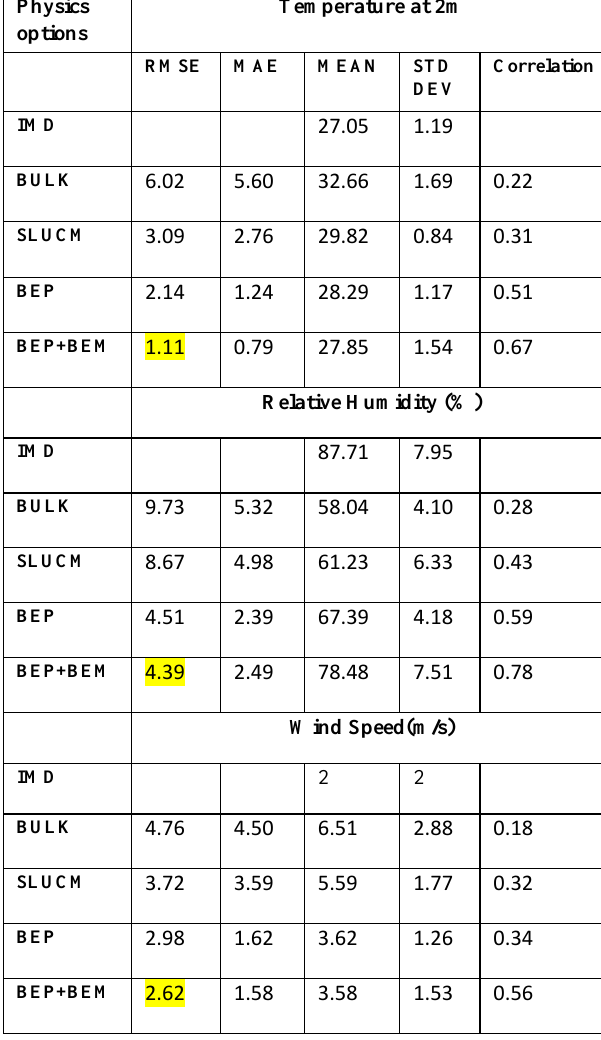
Table 3 Validation of the simulated results of T2